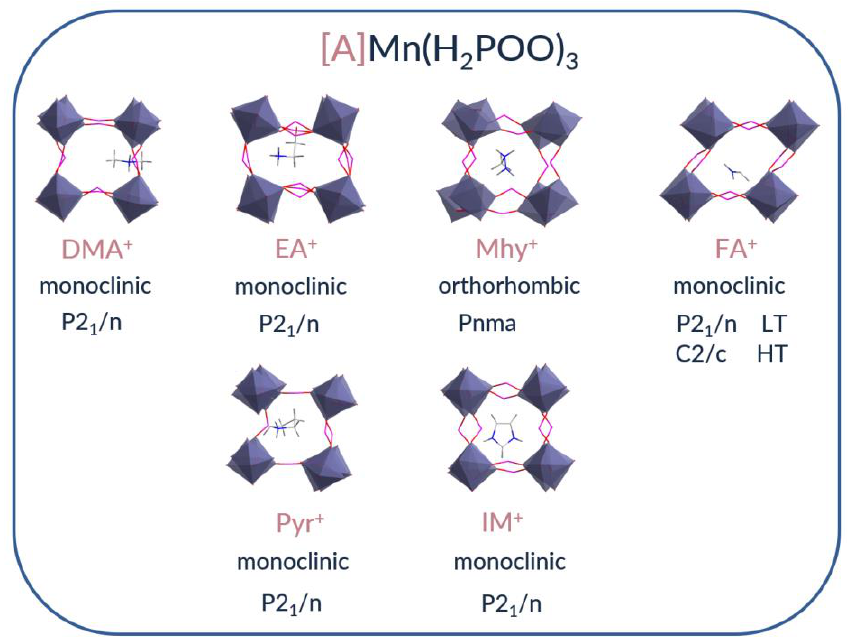
Figure 2. Crystal structures of the investigated manganese hypophosphites.